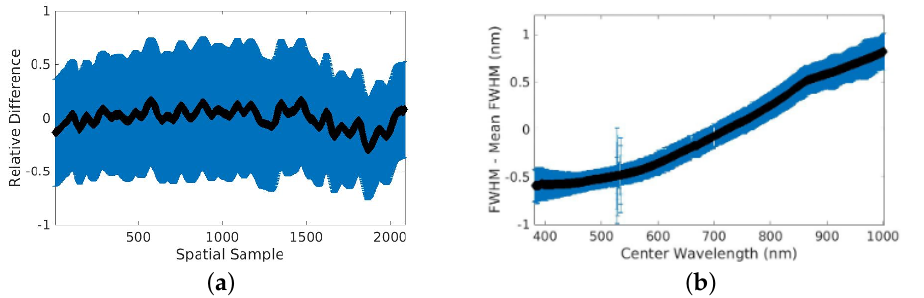
Figure 12. The relative FWHM for ( a ) all of the spectral channels per spatial sample and ( b ) all of the spatial samples per spectral channel denoted by the corresponding center wavelengths.